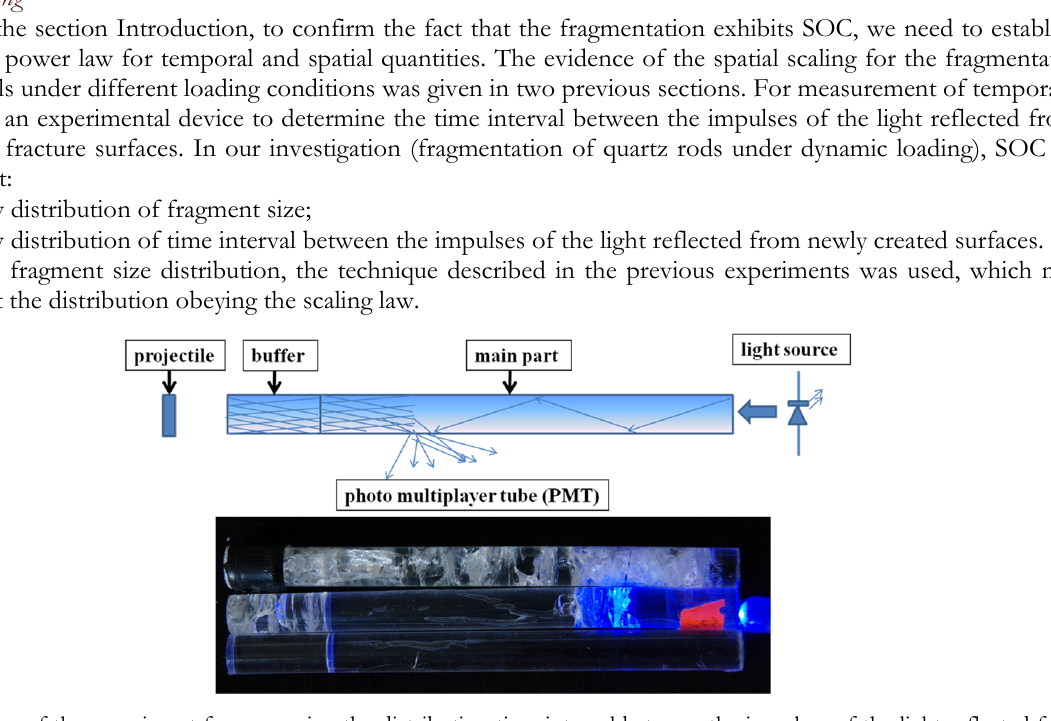
Figure 9: Scheme of the experiment for measuring the distribution time interval between the impulses of the light reflected from the fracture surfaces. The photo of the sample illuminated with the light source.